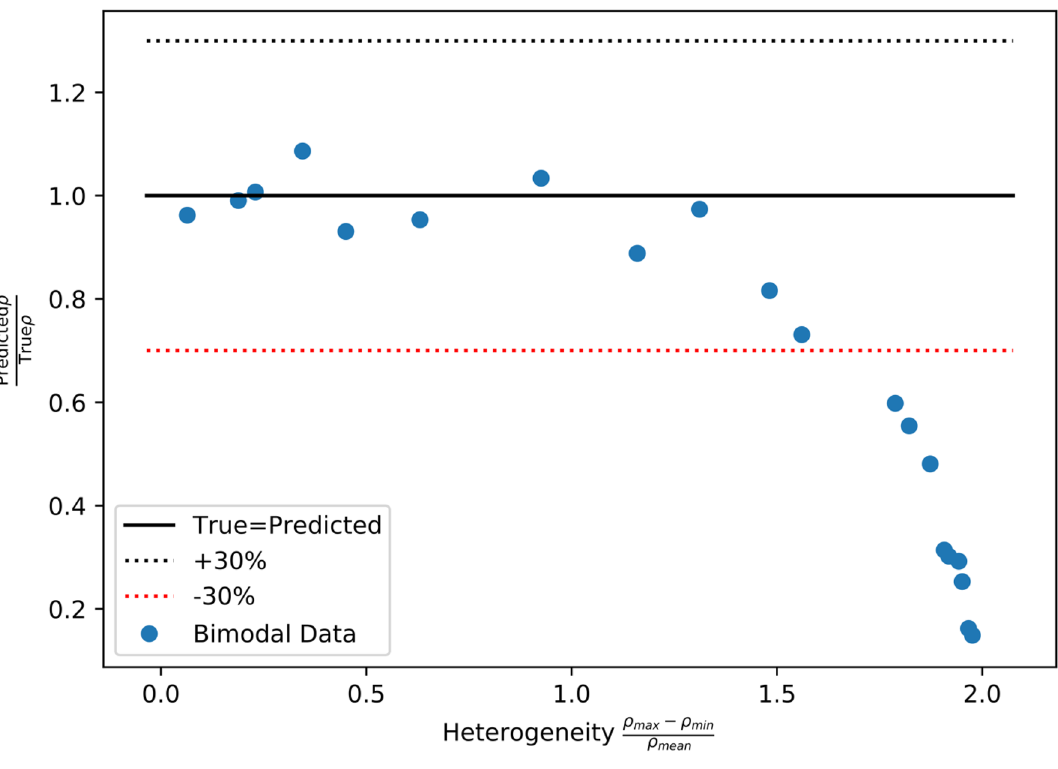
L Figure 8. Predictions of the ǫ -based surrogate model relative to the true values of dislocation density for 20 “bimodal” profiles, as a function of the heterogeneity of the dislocation density between grains.